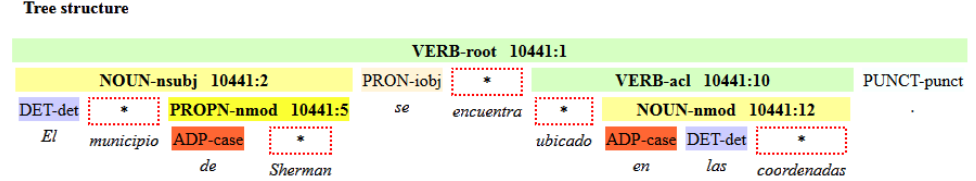
Figure 1. An example of a dependency treebank from Spanish universal